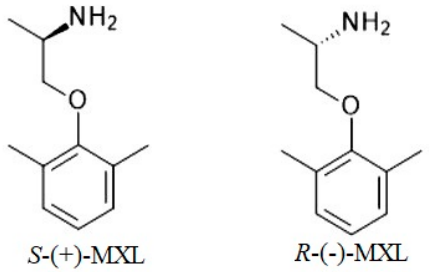
Figure 1. MXL enantiomers’ chemical structures.